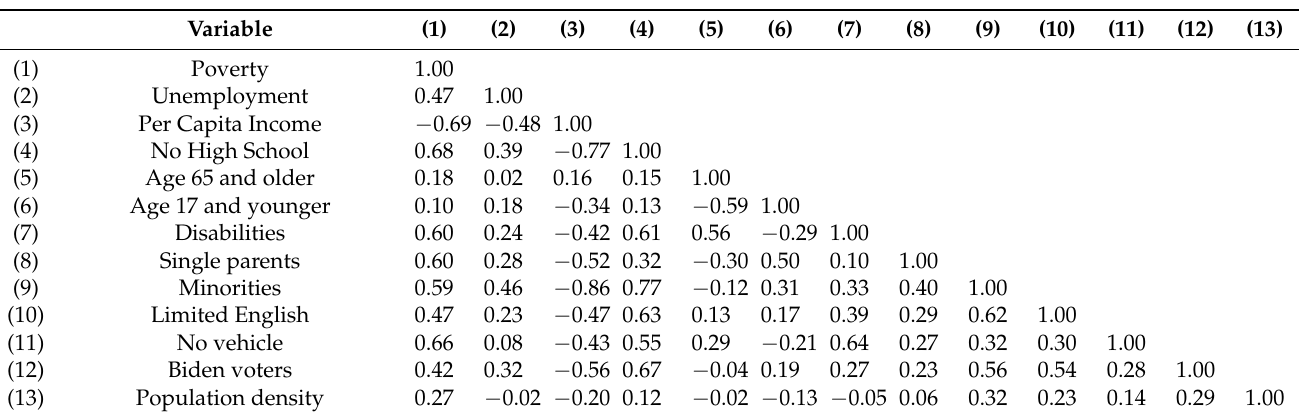
Table 2. Correlation coefficients between explanatory